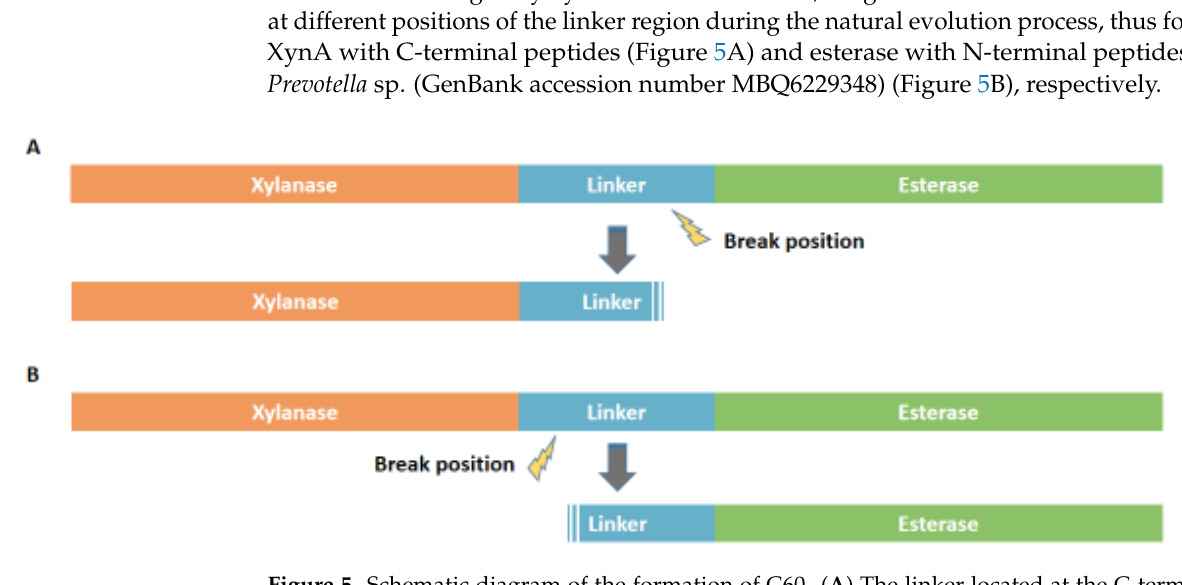
Figure 5. Schematic diagram of the formation of C60. ( A ) The linker located at the C-terminal of xylanase after breaking. ( B ) The linker located at the N-terminal of esterase after breaking.